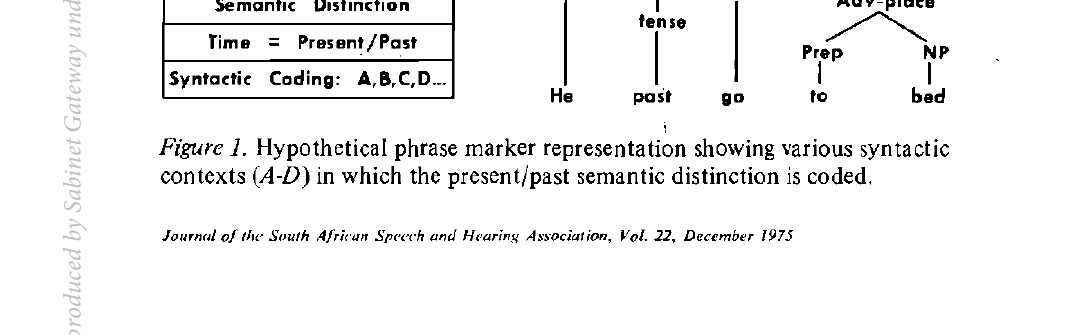
Figure 1. Hypothetical phrase marker representation showing various syntactic contexts (A-D) in which the present/past semantic distinction is